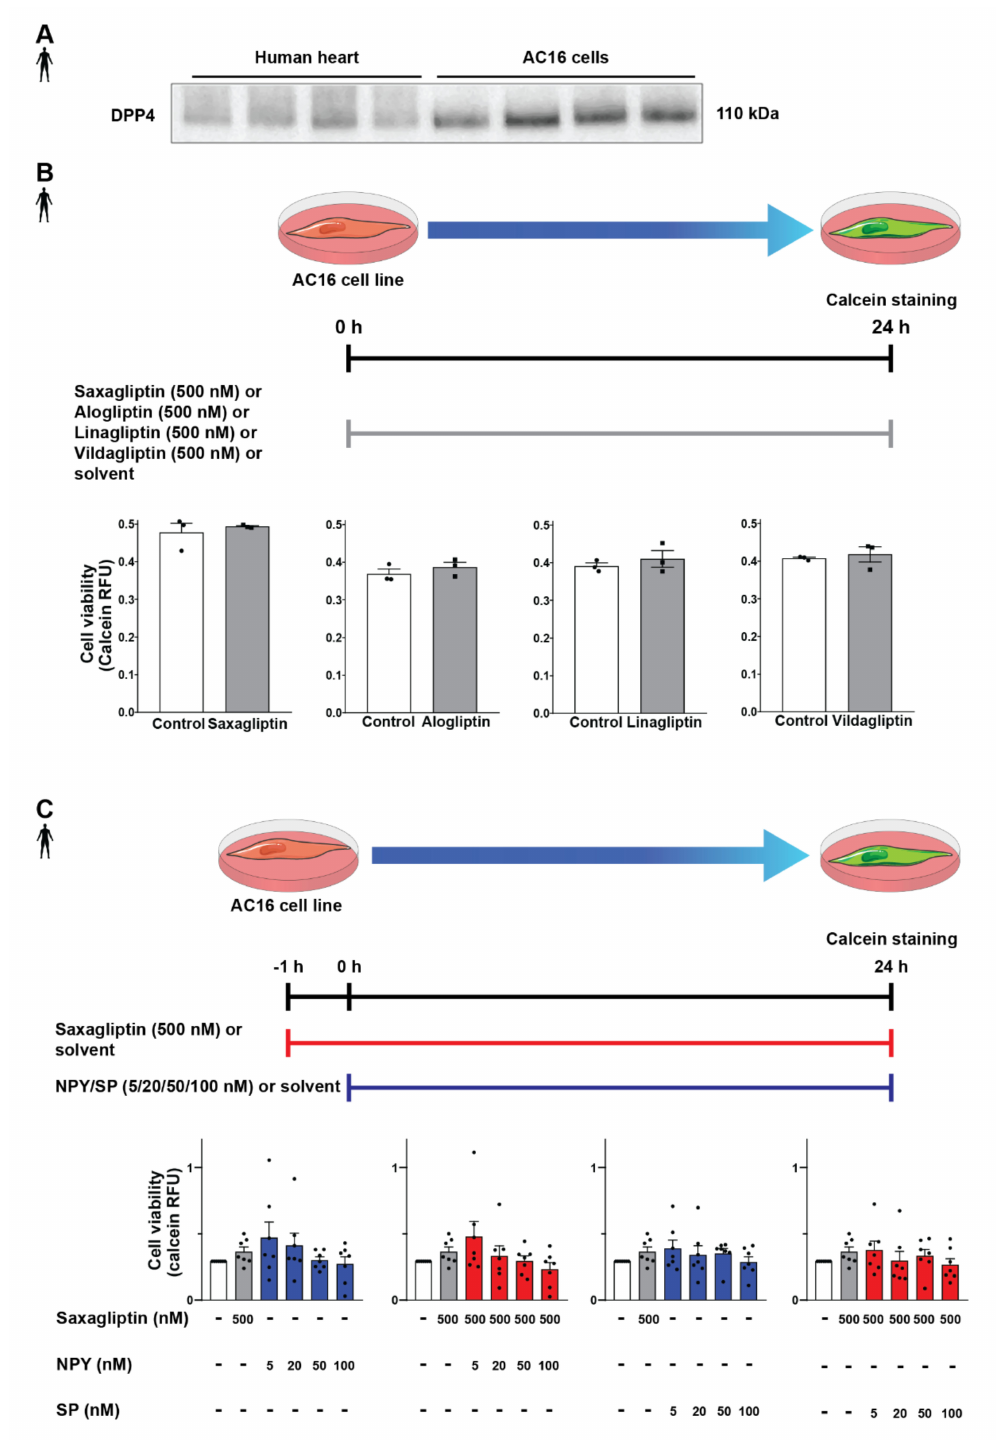
Figure 4. Effect of DPP4 inhibition and/or neuropeptide substrates on the viability of AC16 cells. Western blot analysis of DPP4 ( A ) in healthy human left ventricle samples and AC16 cells. In